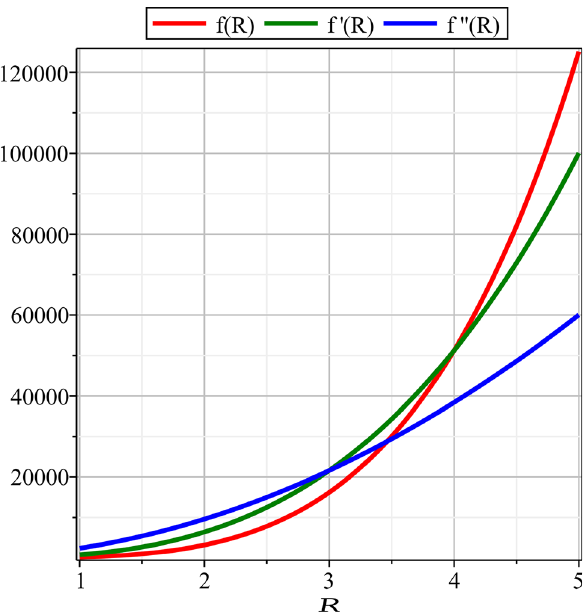
Fig. 2 This figure demonstrates the plots of f ( R ) (red color), f (cid:5) ( R ) (green color), and f (cid:5)(cid:5) ( R ) (blue color) for constant deceleration param- eter case at curvature interval [ 1 , 5